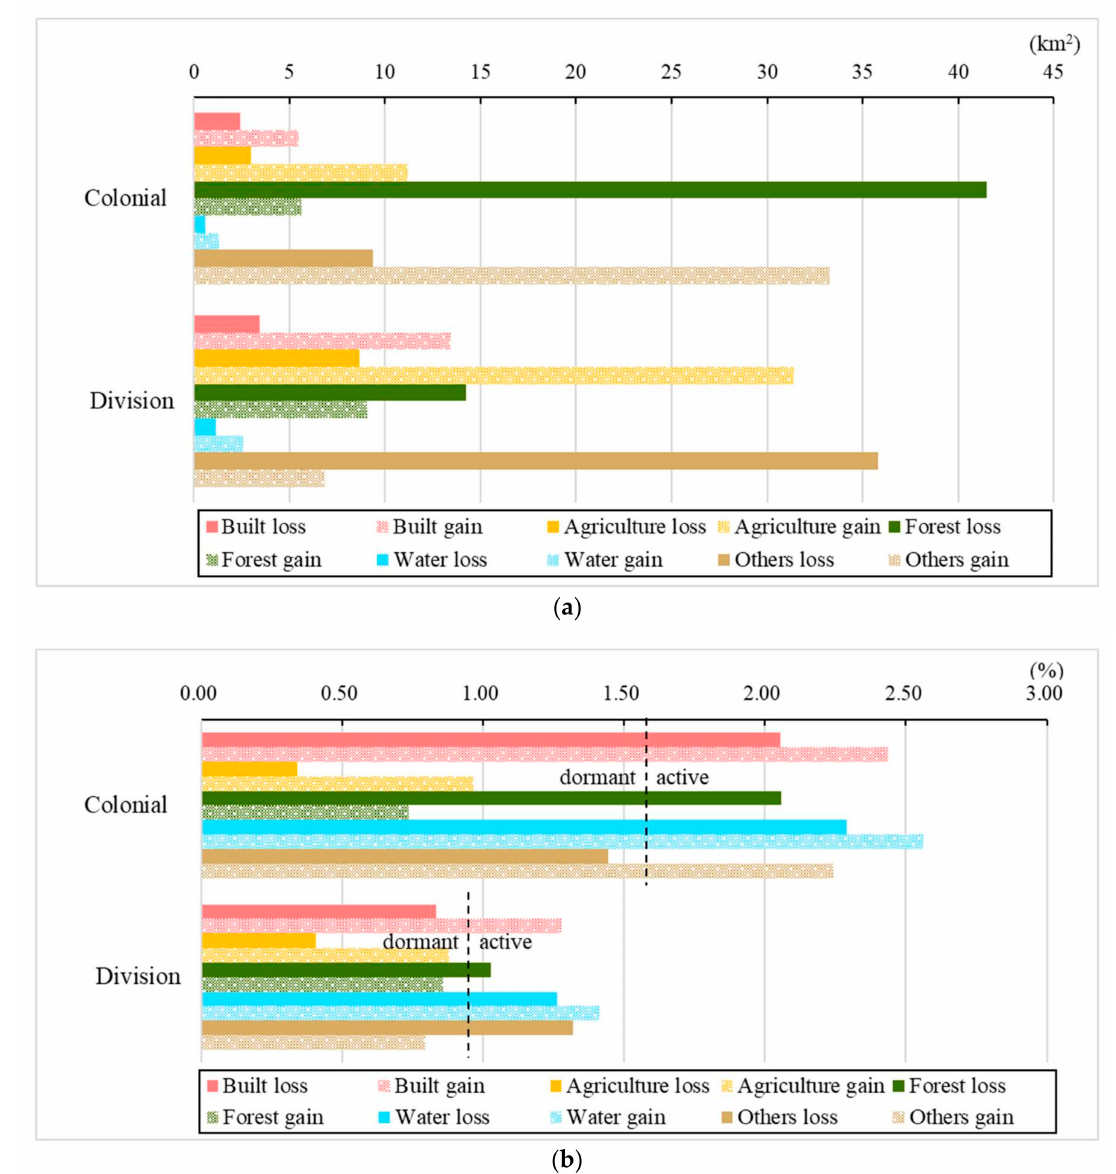
Figure 8. Category level losses and gains by: ( a ) area and ( b ) intensity. Forest during the colonial period (Figure 9a) shows the largest LUCC by area (47.10 km 2 ), largely a result of its Quantity (35.90 km 2 ). This is followed by Others (42.65 km 2 ), where Quantity (23.94 km 2 ) is also the largest change component. Agriculture similarly shows more Quantity than the other two components, whereas Built and Water demonstrate more Exchange than Quantity (Figure 9a). During the division (Figure 10b), Others shows the largest LUCC (42.68 km 2 ), followed by Agriculture (40.03 km 2 ), for which Quantities contributed to the majority of both changes (28.98 km 2 and 22.72 km 2 , respectively). In this latter period, Built also shows greater Quantity than the other two components, indicating more substantial one-way changes compared to the colonial period (Figure 9a,b). As for Forest and Water, Exchange is the major contributor to their LUCCs (Figure 9b). Further, while no Shift was observed for Forest during the colonial period (Figure 9a), more Shift than Quantity was seen during the division (Figure